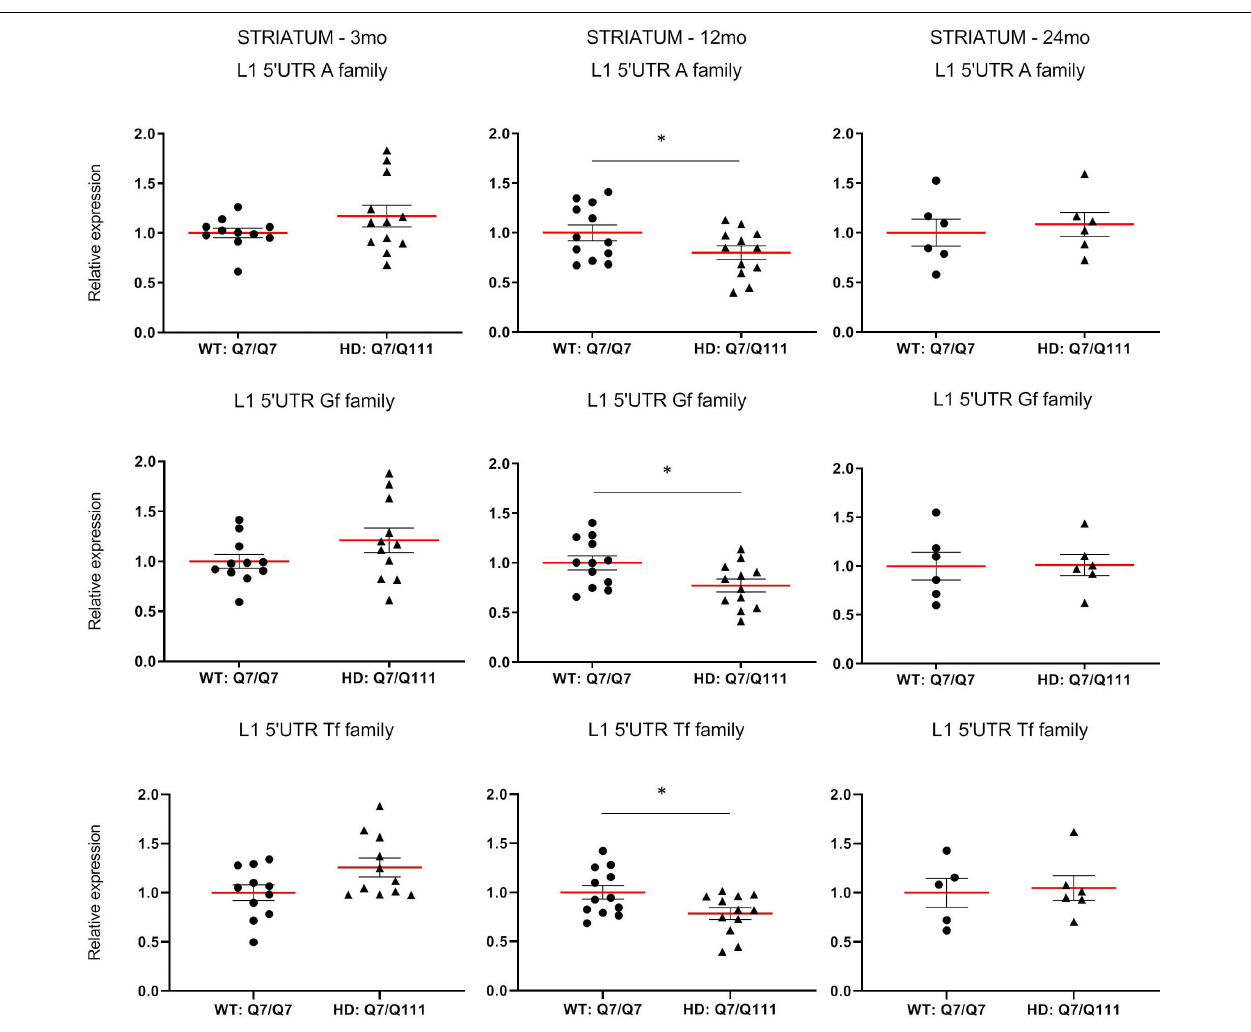
FIGURE 3 | Expression of full-length L1s mRNA in postnatal striatum of HD and WT mice. Relative quantification of L1 5 (cid:48) UTR levels in the striatum of WT: Q7/Q7 and HD: Q7/Q111 mice at 3, 12, and 24 mo of age. Relative L1 5 (cid:48) UTR expression levels are normalized with the housekeeping gene UbC. Each dot results from 3 independent qPCR replica on each sample. Mean value is shown with red bar. Error bars indicate SEM. ∗ P < 0.05 resulting from Mann Whitney unpaired test. Groups for 3 and 12 mo mice are composed by 12 biological replicates ( n = 12). Groups for 24 mo mice are composed by 6 biological replicates ( n = 6).